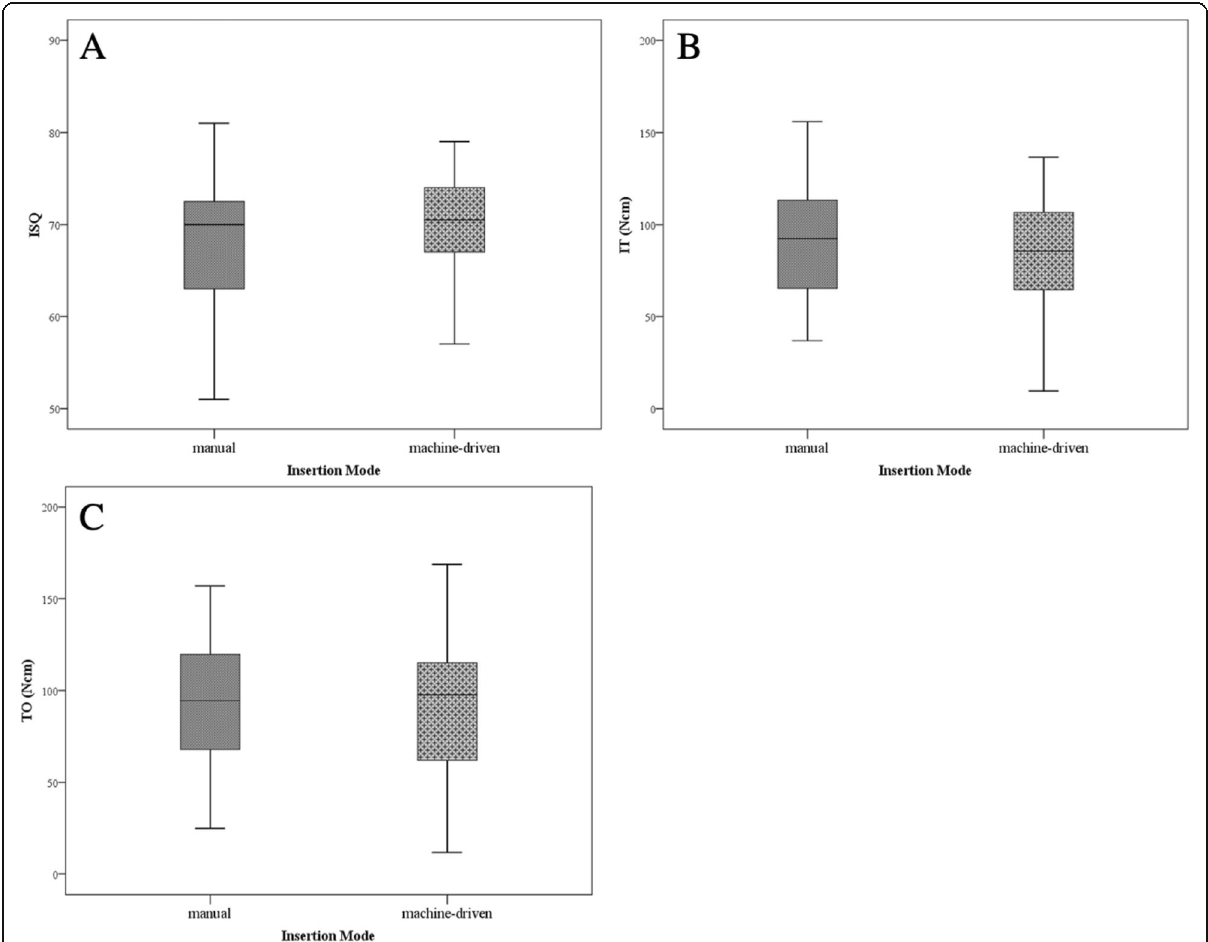
Fig. 4 Comparison of manual and machine-driven insertion mode. This figure displays the comparison between manual and machine-driven insertion mode. a Displays the results obtained by the RFA test, indicated as ISQ (0 – 100). b Displays the measurements obtained by the torque in and c by the torque out test. There was no statistically significant difference between the groups. ISQ, implant stability quotient; IT, insertion torque; TO, torque